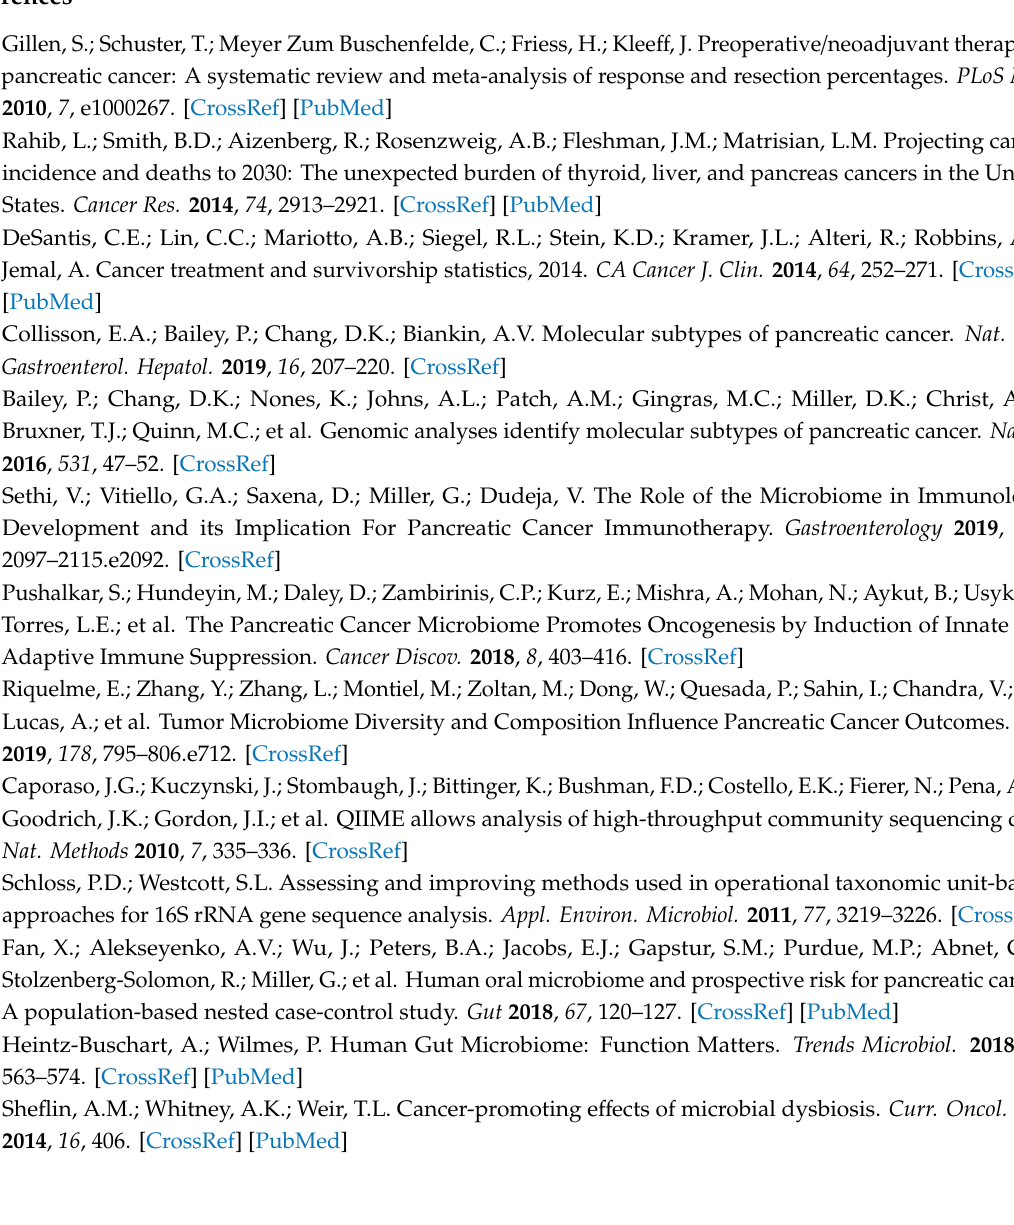
Figure S8. Proliferation of cancer cells in the presence of the supernatant of TF in Capan2 and SNU213. Figure S9. Proliferation of cancer cells in the presence of the culture medium of Tepidimonas fonticaldi in Panc 10.05 and CFPAC-1 cells. Figure S10. Proliferation of cancer cells in the presence of the supernatant of Tepidimonas fonticaldi and Gemcitabine in SW1990 and CFPAC-1 cells. Figure S11. Alterations in the protein of SNAIL with the presence of the supernatant of Tepidimonas fonticaldi in HPAF-II and Panc 10.05 cells. Figure S12. Regulation of transcription factors associated epithelial to mesenchymal transition (EMT) by Tepidimonas fonticaldi in Panc 10.05 cells. Figure S13. Alteration of cancer metabolite by the supernatant of Tepidimonas fonticaldi in SW1990